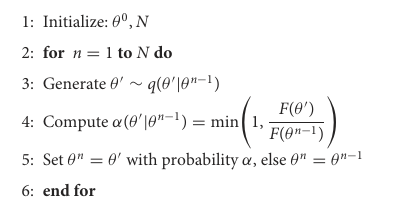
Algorithm 2. Note the directing analogy between this and Algorithm 1. Algorithm 2 Simulated